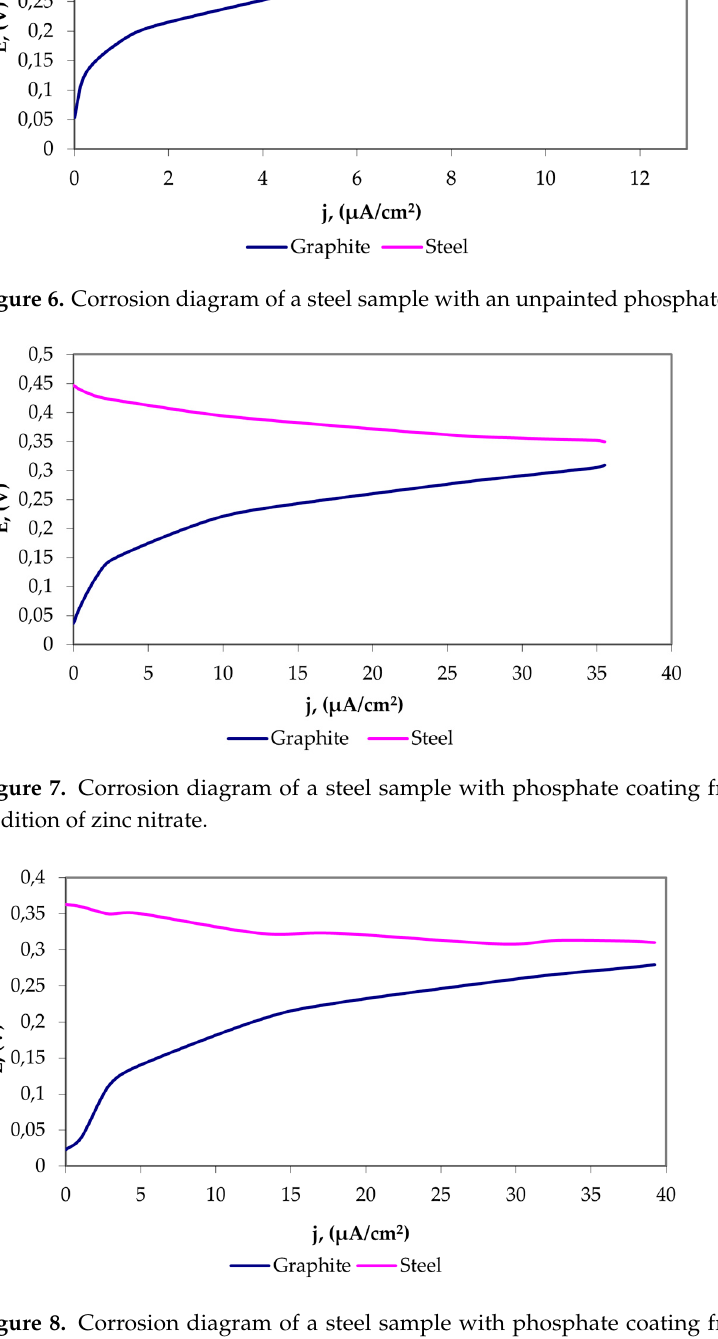
Figure 9. Diffractogram of unpainted phosphate coating.